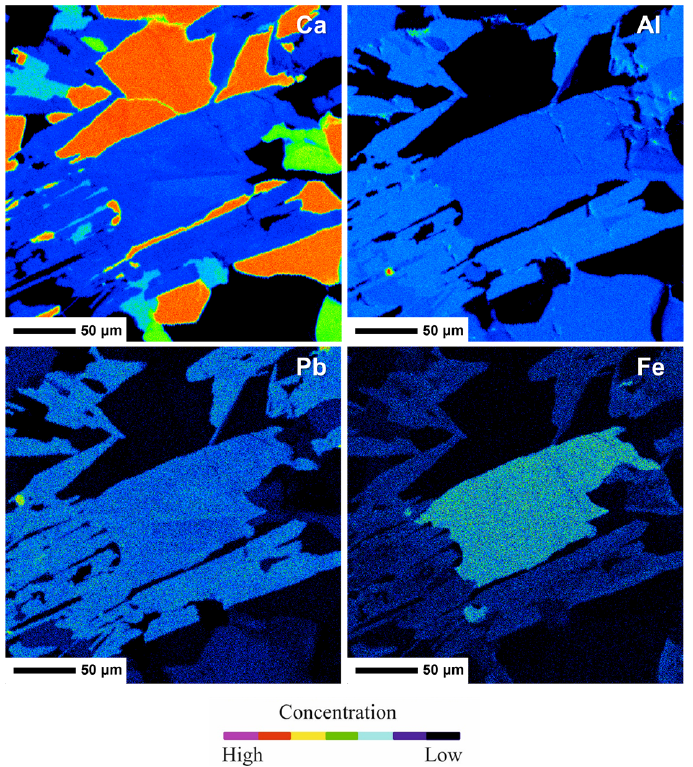
Figure 3. X-ray maps showing the distribution of Ca, Pb, Al, and Fe in the studied sample. Scale bar = 50 μ m.